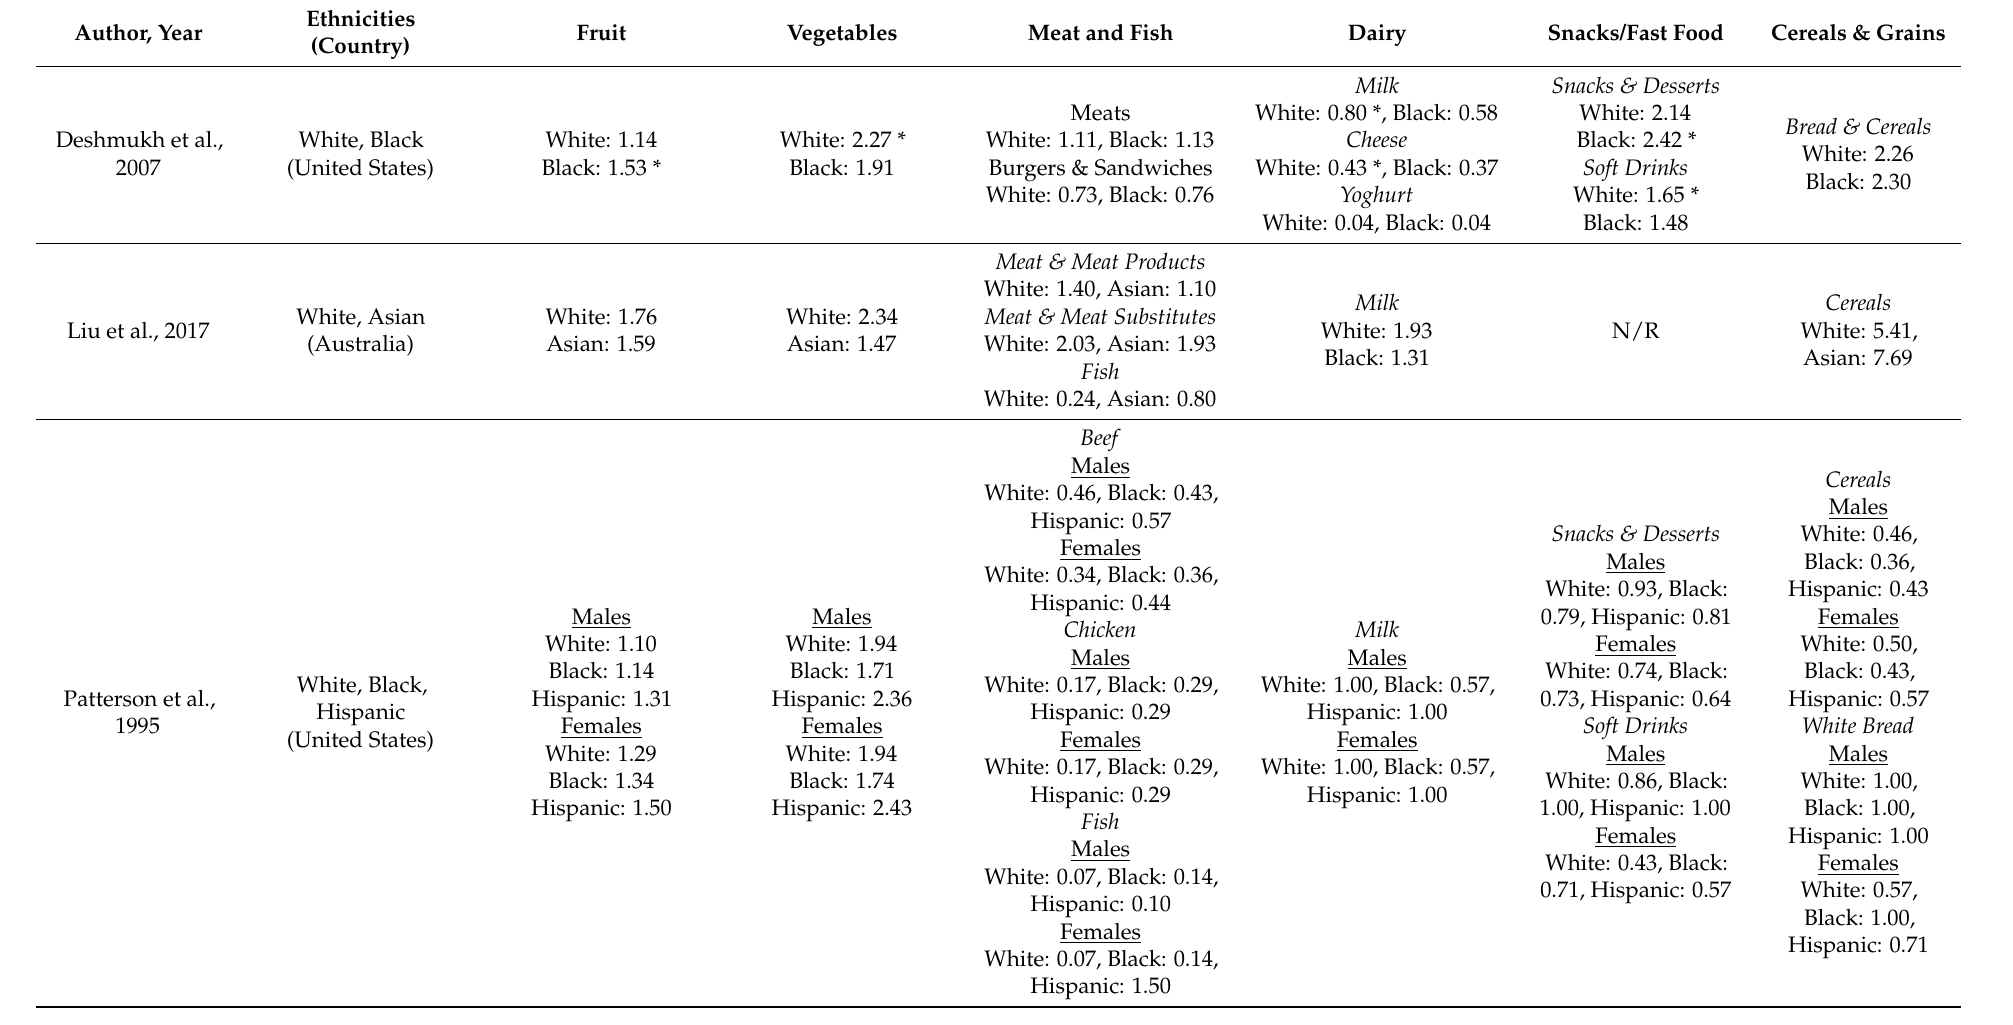
Table 1. Mean daily servings of food groups across different ethnic